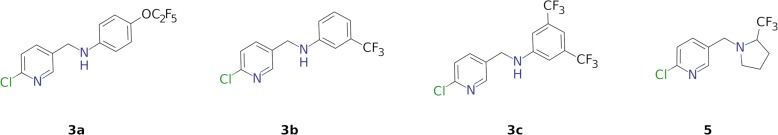
New neonicotinoids containing fluorinated acceptor groups.